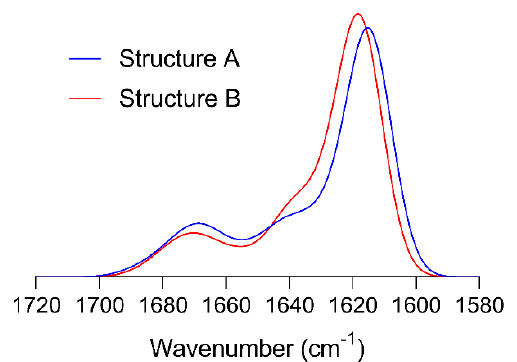
Figure 2. Simulated amide I spectra for the antiparallel β -sheet structures A and B [70].